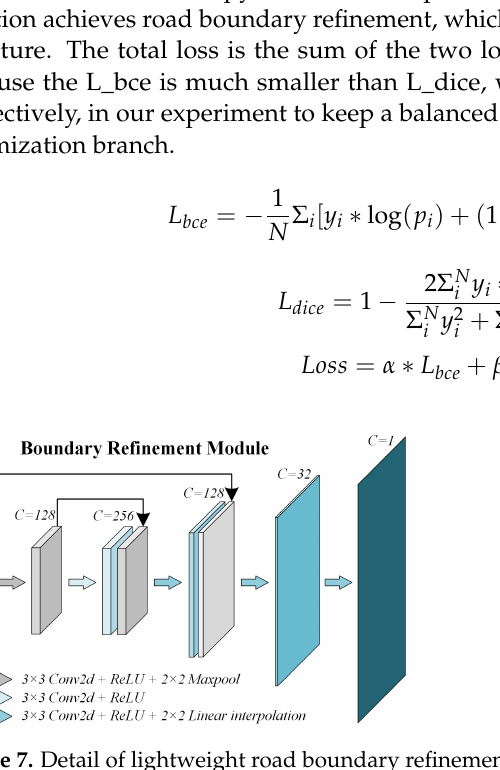
Figure 7. Detail of lightweight road boundary refinement